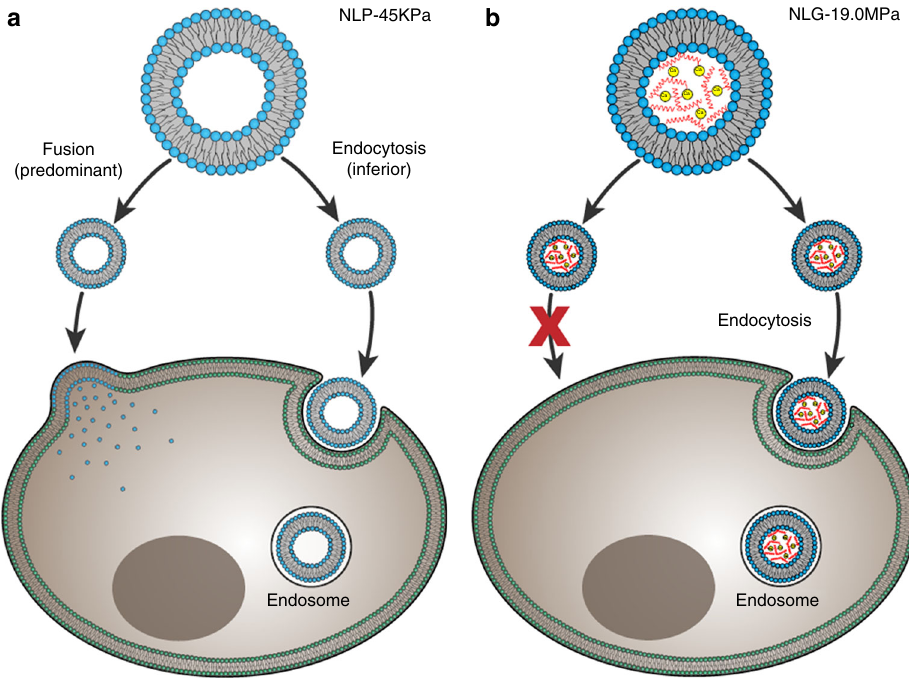
Fig. 3 Cell internalization pathway shift by varying particle elasticity. Soft NLP-45KPa ( a ) enters the cell via two pathways: fusion (predominant) and endocytosis (inferior). Hard NLG-19MPa ( b ) enters cell via only clathrin-mediated